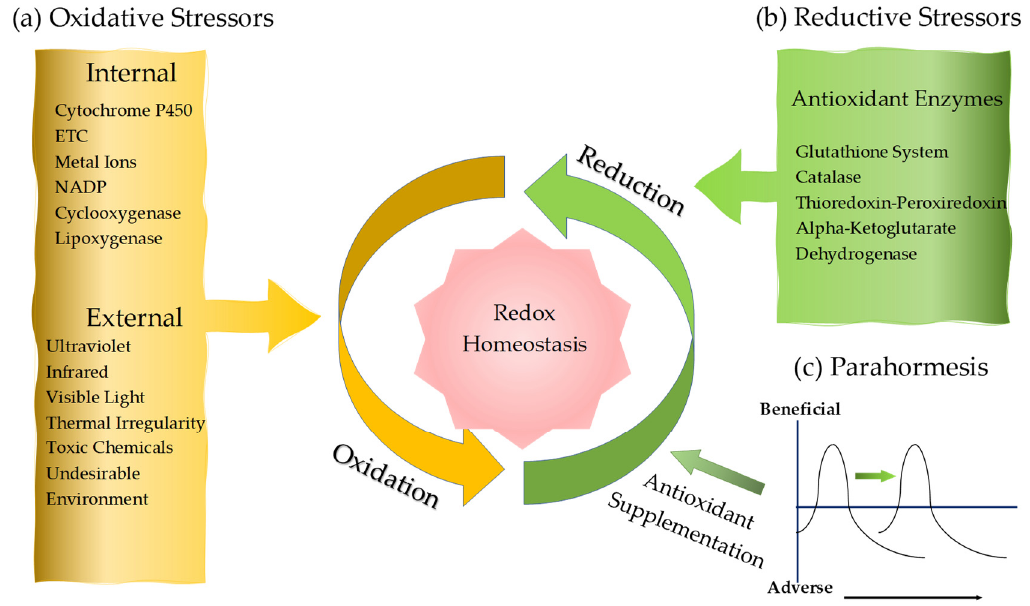
Figure 1. Redox homeostasis and antioxidant supplementation. ( a ) Oxidative stressors comprise of external and internal stressors, exerting oxidative chemical reactions in organism. Oxidation is an indispensable bioenergetic process to sustain life. ( b ) Reductive stressors are products of antioxidative enzymes that generate antioxidants in response to regular oxidation activity and increased oxidative stress. ( c ) Antioxidant supplementation attempts to shift the biphasic response from adverse to beneficial phase to maintain nucleophilic tone. This mechanism is called parahormesis.